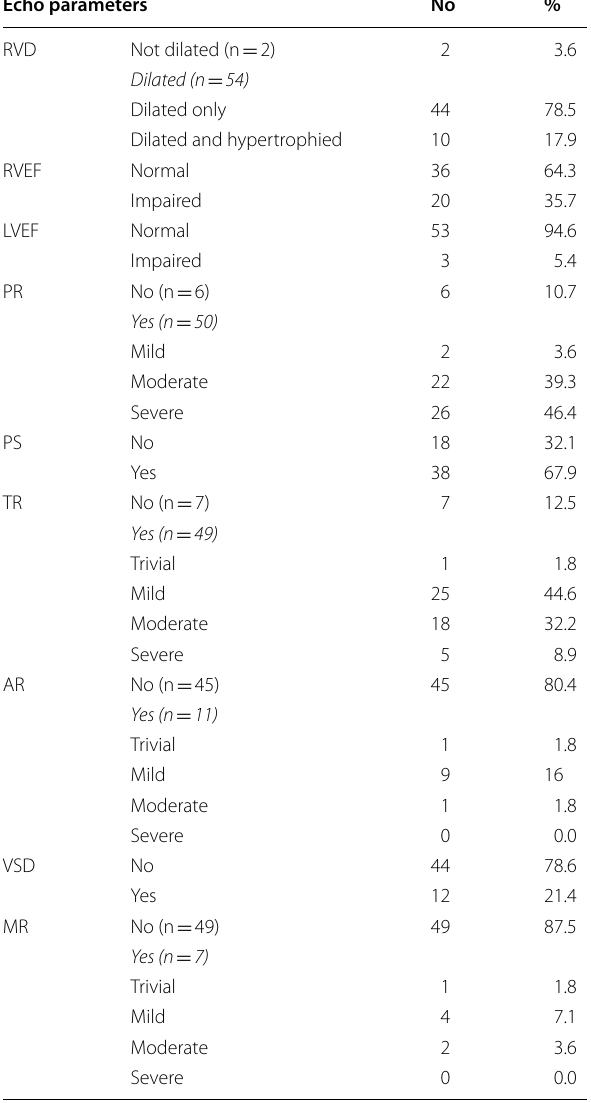
Table 4 Distribution of the 56 rTOF patients according to different Echo